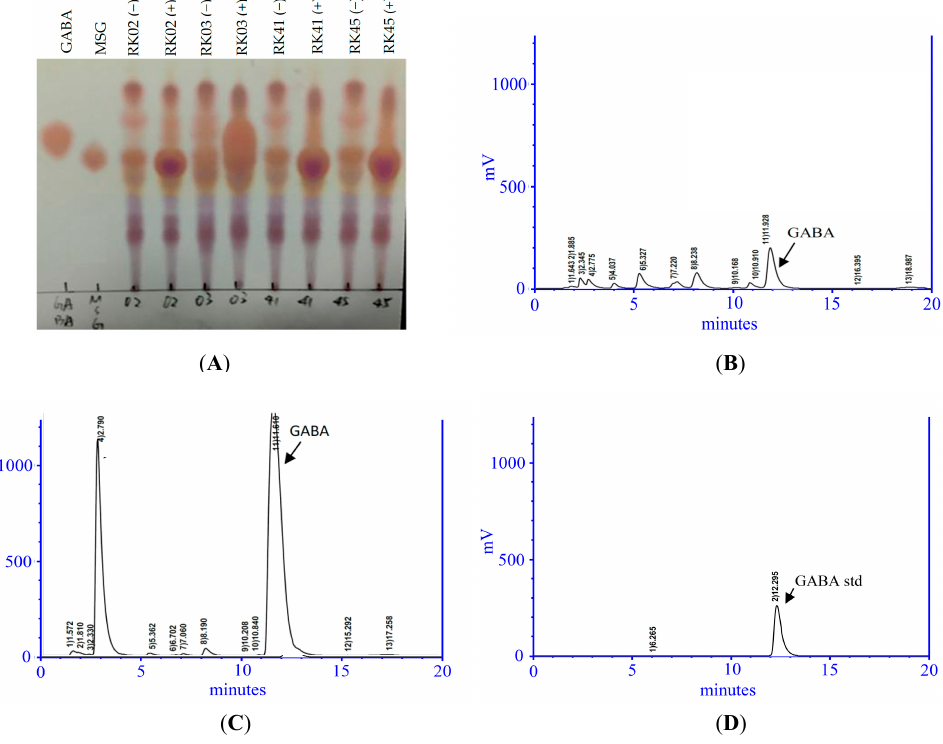
Figure 1. Characteristics of L. brevis RK03 isolated from Priacanthus macracanthus . ( A ) Thin layer chromatography (TLC) profiles of γ -aminobutyric acid (GABA) and monosodium glutamate (MSG) standards and selected filtration of lactic acid bacteria (LAB) cultures with (+) or without ( − ) MSG. High performance liquid chromatography (HPLC) analysis of supernatants from L. brevis RK03 cells cultured in: ( B ) Man, Rogosa and Sharpe (MRS) medium; and ( C ) MRS medium supplement with 1% MSG; ( D ) GABA standard. These data represent two different separate experiments.